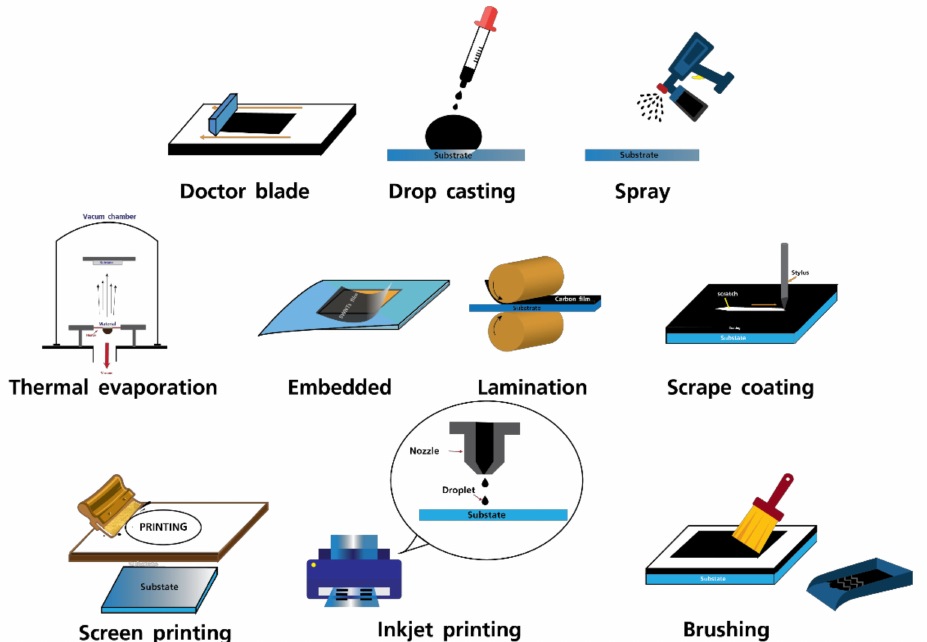
Figure 3. Schematic illustration of several techniques for fabrications of carbon electrodes in per- ovskite solar